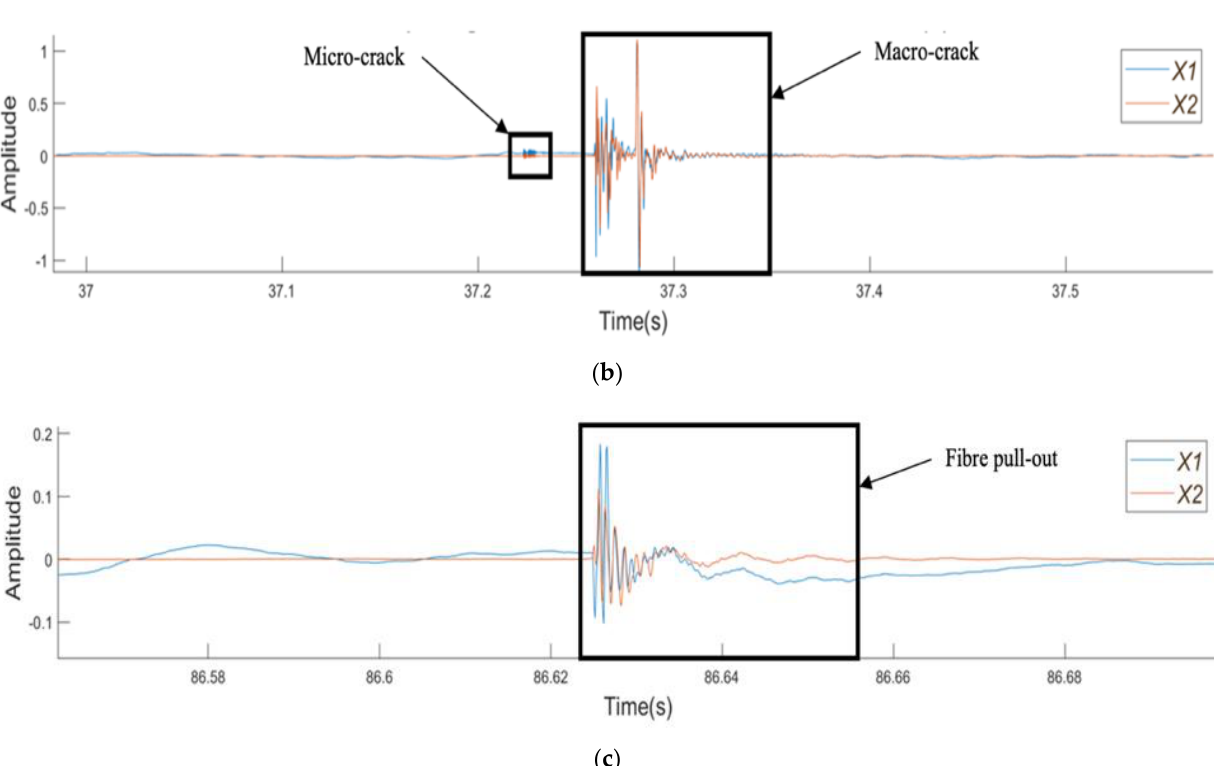
Figure 6. Amplitude vs. time plots for SFRSCC beam: ( a ) the complete test; ( b ) the section highlighting micro- and macrocrack regions; and ( c ) the section highlighting the fibre pull-out region.